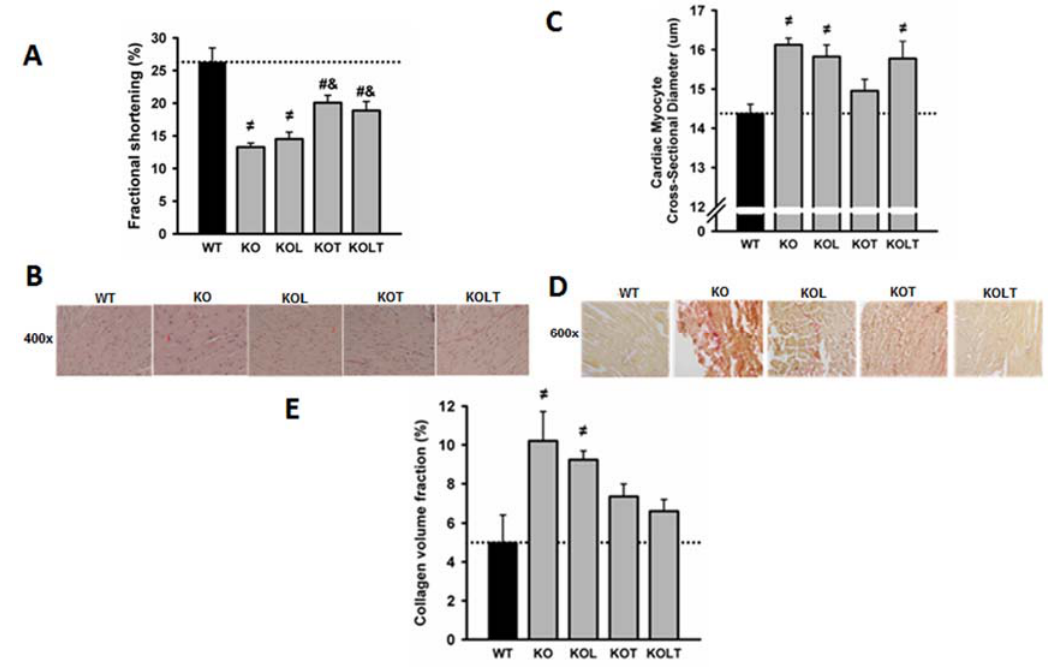
Figure 2. Fractional shortening ( A ); representative microphotographs of left ventricle cross-sections ( B ); cardiac myocyte cross-sectional diameter ( C ); representative microphotographs of cardiac collagen volume fraction ( D ) and cardiac collagen volume fraction ( E ) in wild type (WT), α 2A / α 2C ARKO mice placebo (KO) or leucine (KOL), and exercise trained (KOT) or exercise trained and leucine-supplemented (KOLT). Data are presented as mean ± SE. n = 7–9 per group. ≠ p < 0.05 vs. WT; # p < 0.05 vs. KO; & p < 0.05 vs.